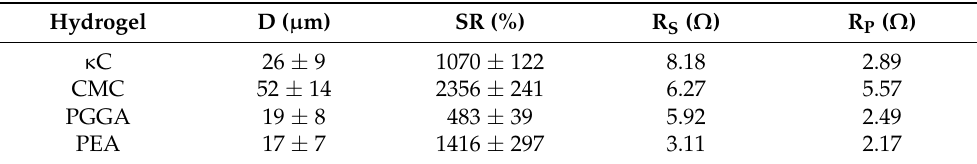
Table 1. Diameter of the micropores (D), swelling ratio (SR) and resistance (R p ) of the four stud- ied hydrogels.